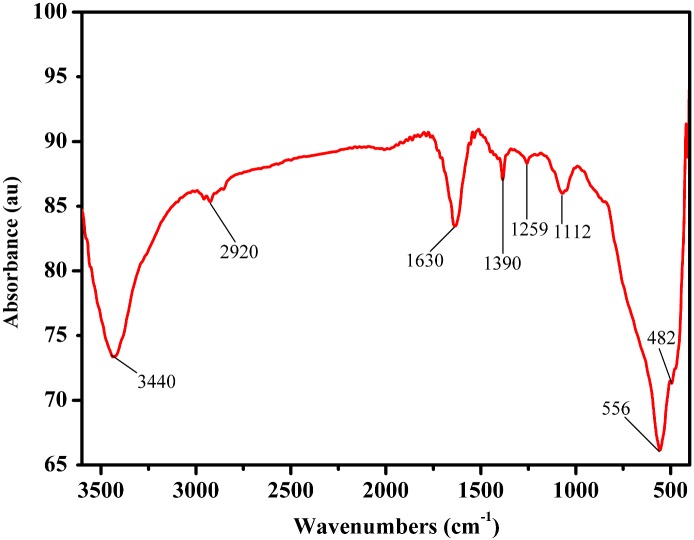
FT-IR spectrum of CuS-GeO2-TiO2 composite coating.